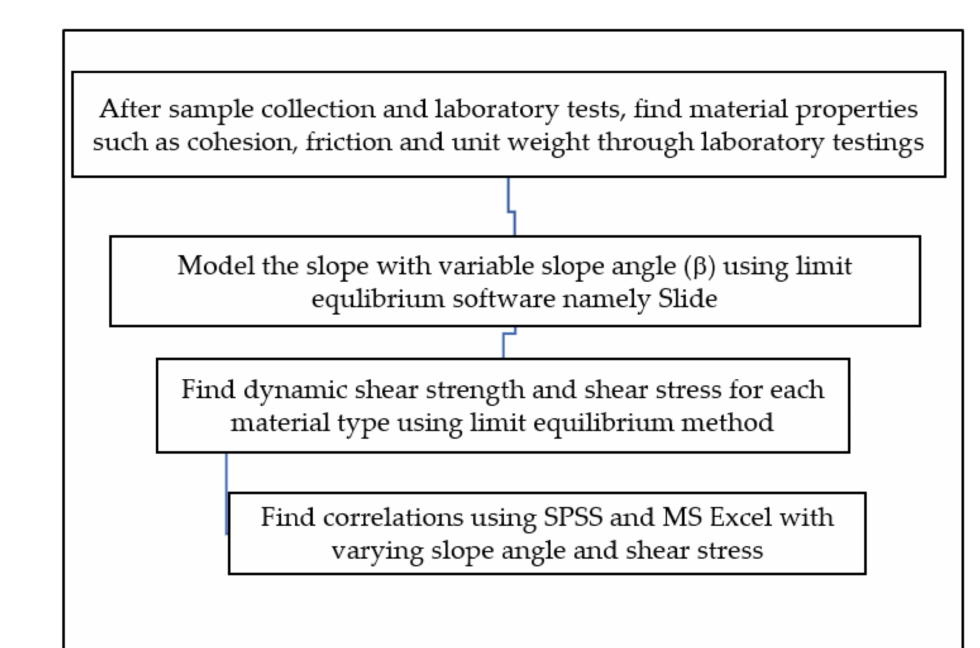
Figure 4. Methodology